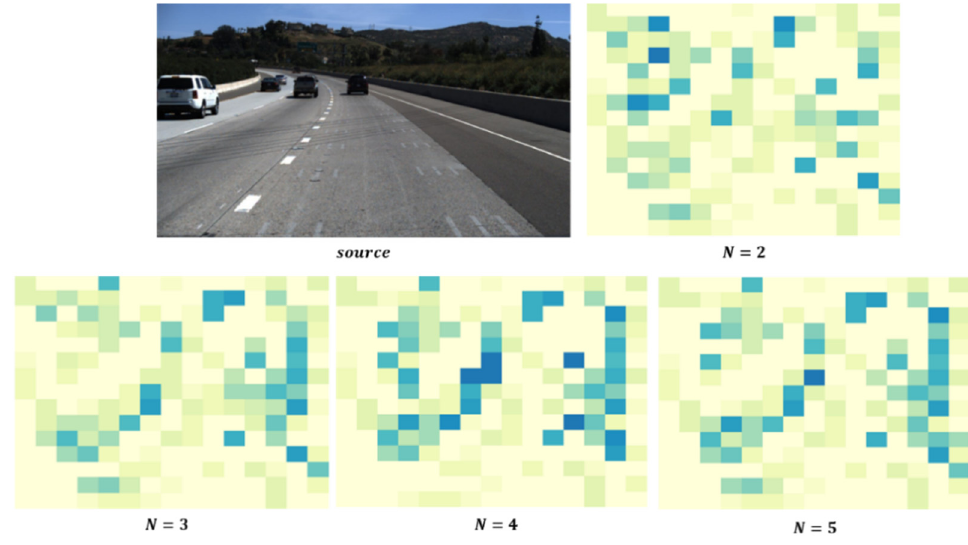
Figure 6. Heat map of encoding modules. N is the encoding modules number ( N = 2,3,4,5 ) . The encoder modules can capture contextual feature information and slender structures of lane lines.